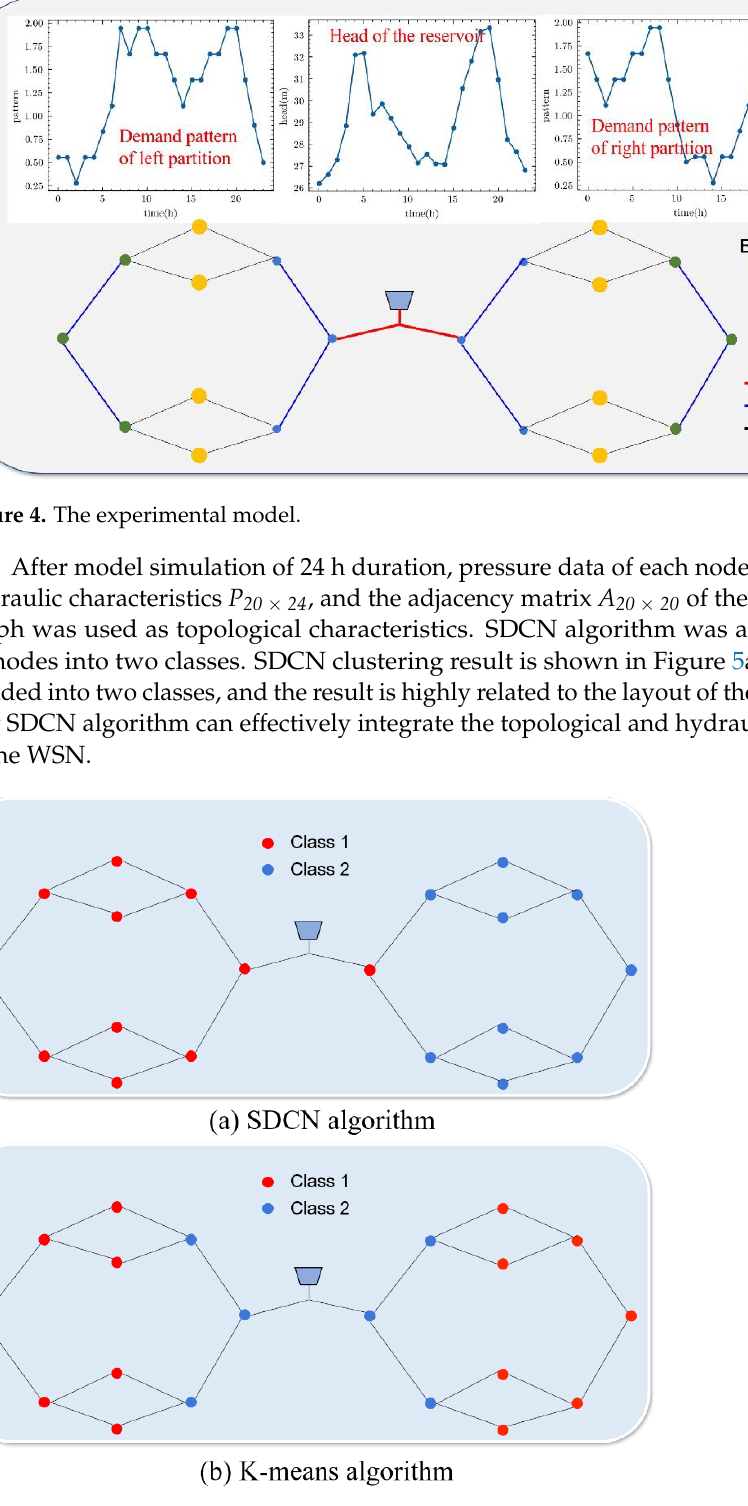
Figure 5. Compassion of clustering